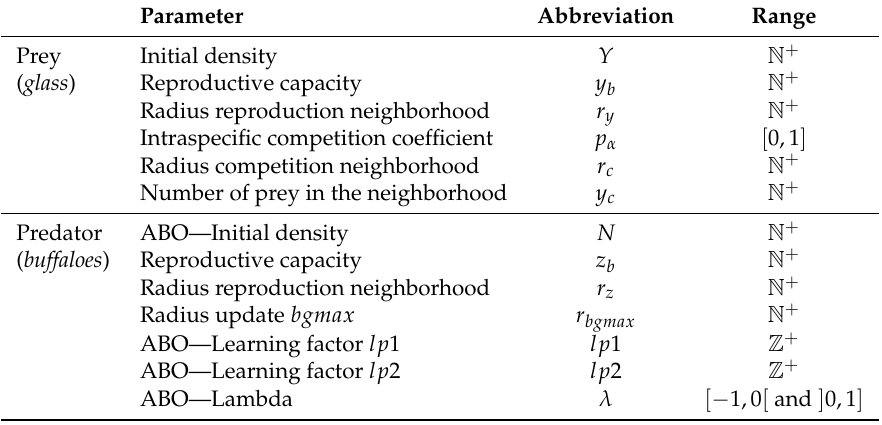
Table 1. Abbreviations used in the dynamic prey–predator spatial model